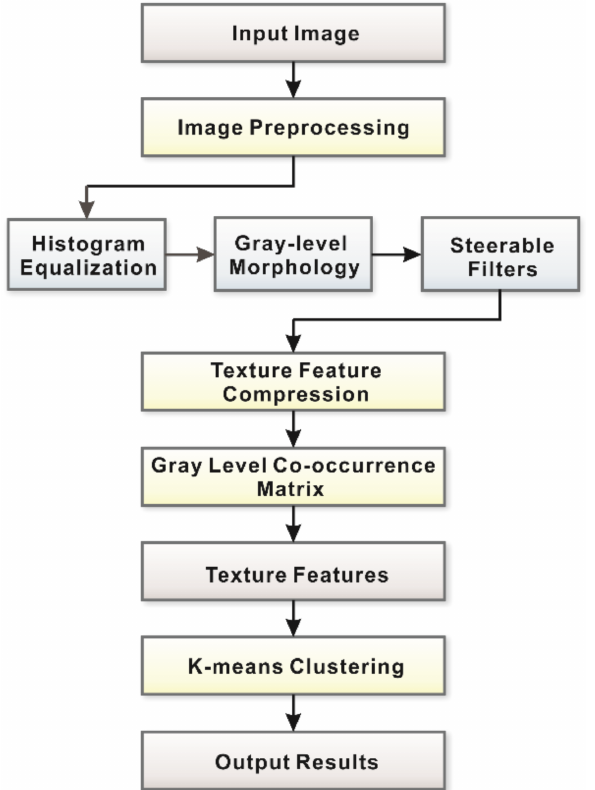
Figure 5. The flowchart of the proposed defect automatic inspection